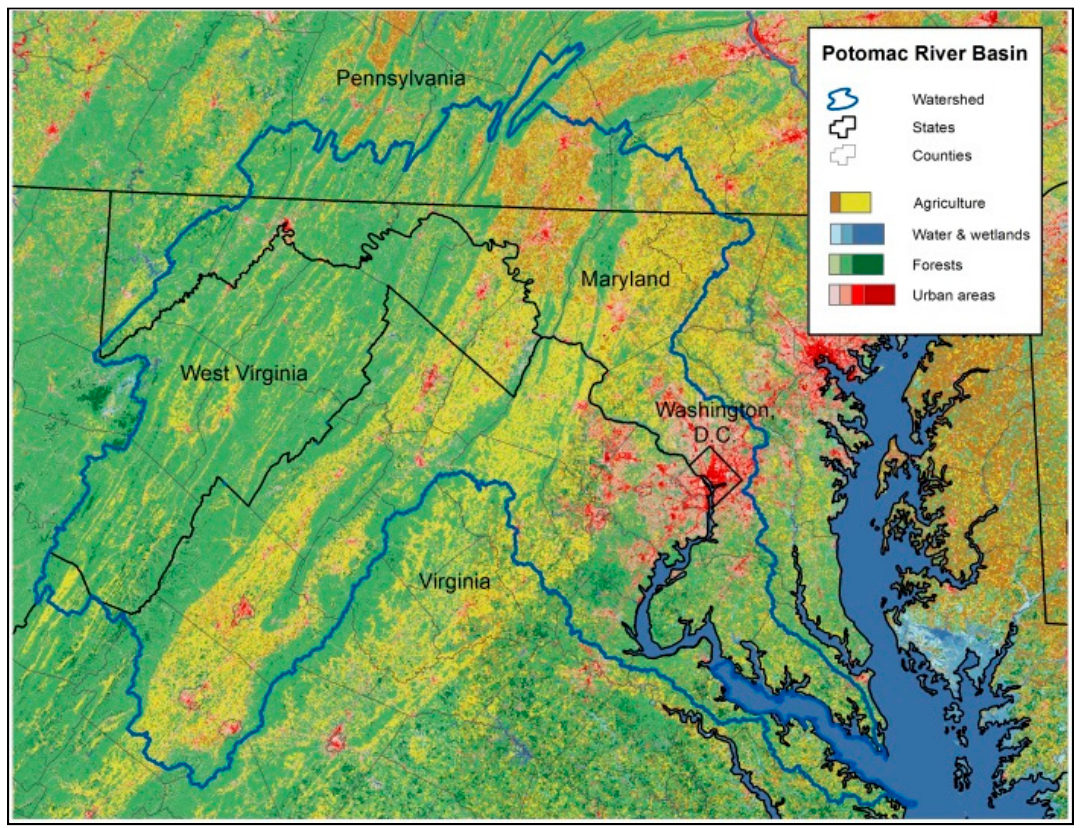
Figure 1. The probability of stream burial was modeled for streams across the entire Potomac River Basin PRB), which spans portions of four states (MD, PA, VA, WV) and all of Washington, DC